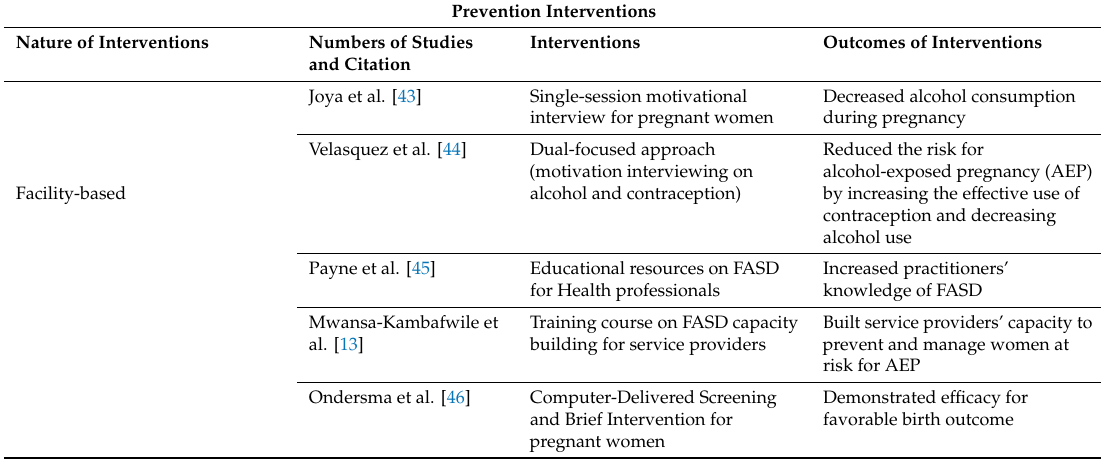
Table 4. Themes generated from the prevention interventions.